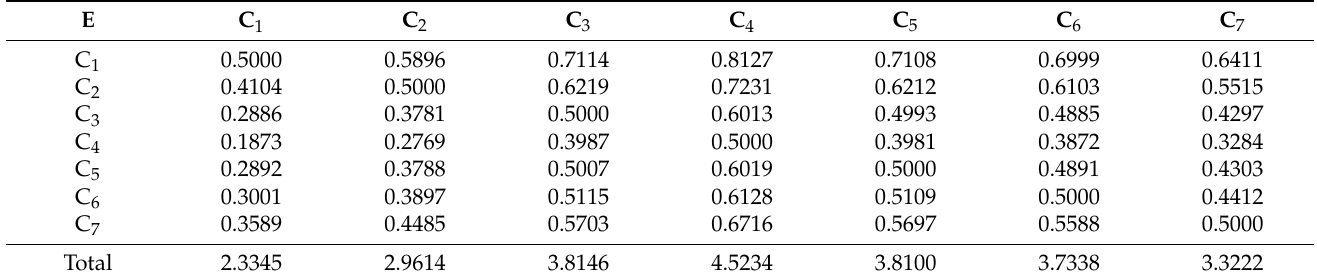
Table 9. Aggregated pairwise comparison matrices of 15 evaluators in Taiwan.